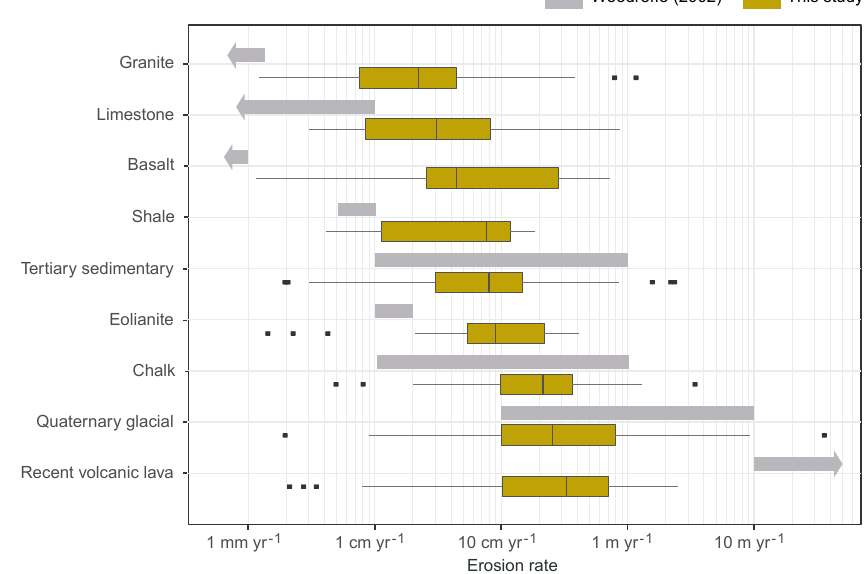
Figure 10. Ranges of erosion rates within different lithology. Comparison between the study by Woodroffe 2002 and this study.